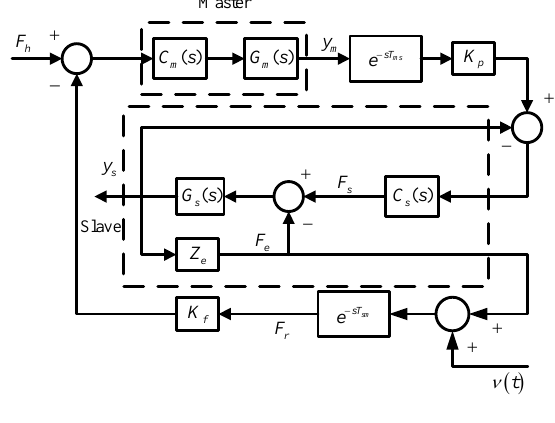
Figure 2. Teleportation system